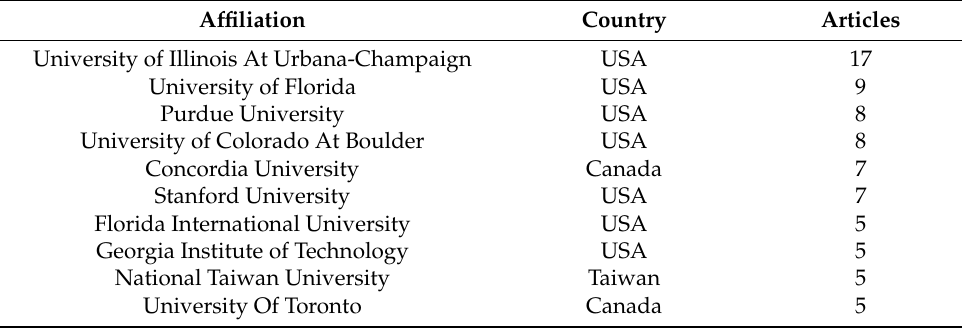
Table 9. Affiliation and institution ranked per published